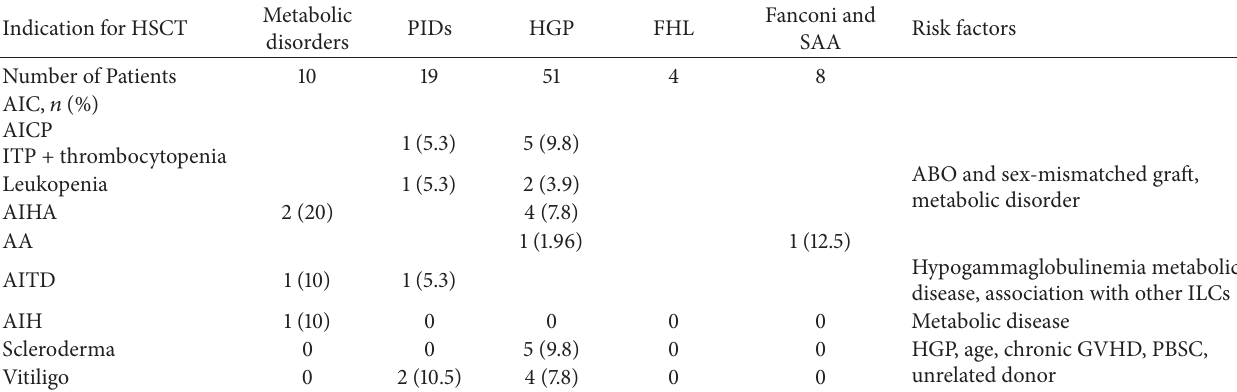
Table 1: Patient